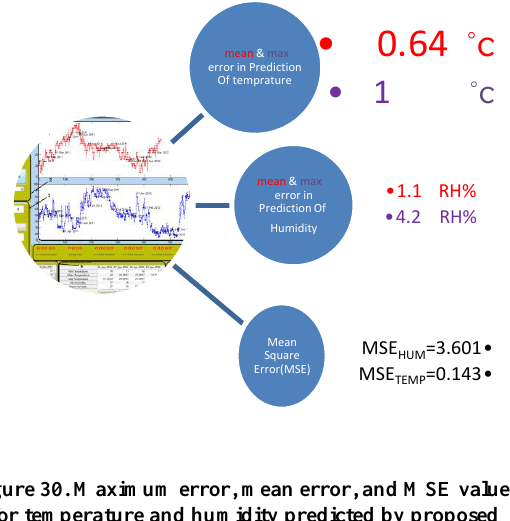
Figure 30. Maximum error, mean error, and MSE values for temperature and humidity predicted by proposed system.